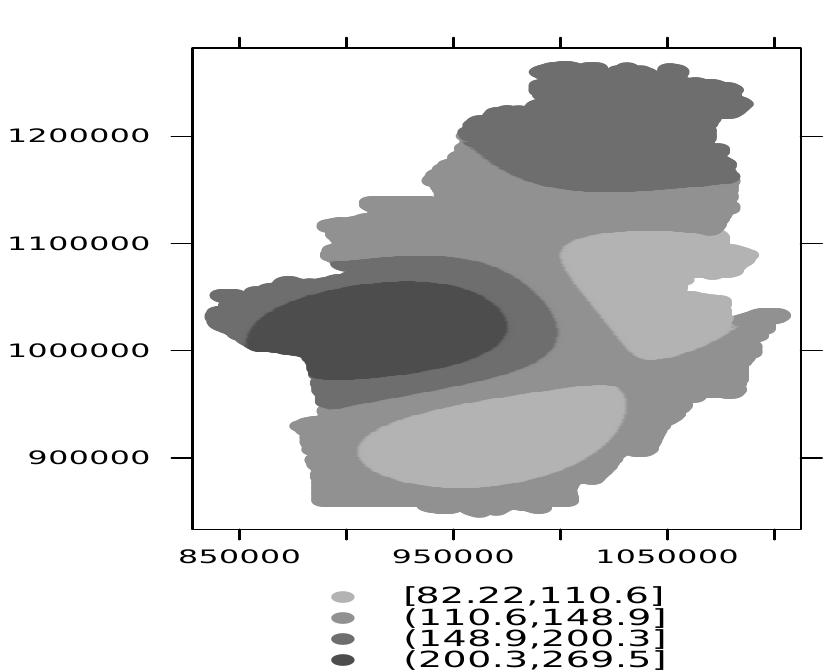
Figure 4. Map of PM10 predictions in the Bogotá area obtained with cokriging and a secondary variable corresponding to WS curves.